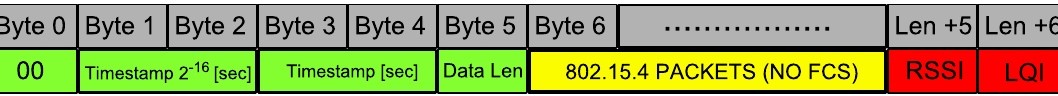
Figure 3. IEEE 802.15.4 packet.